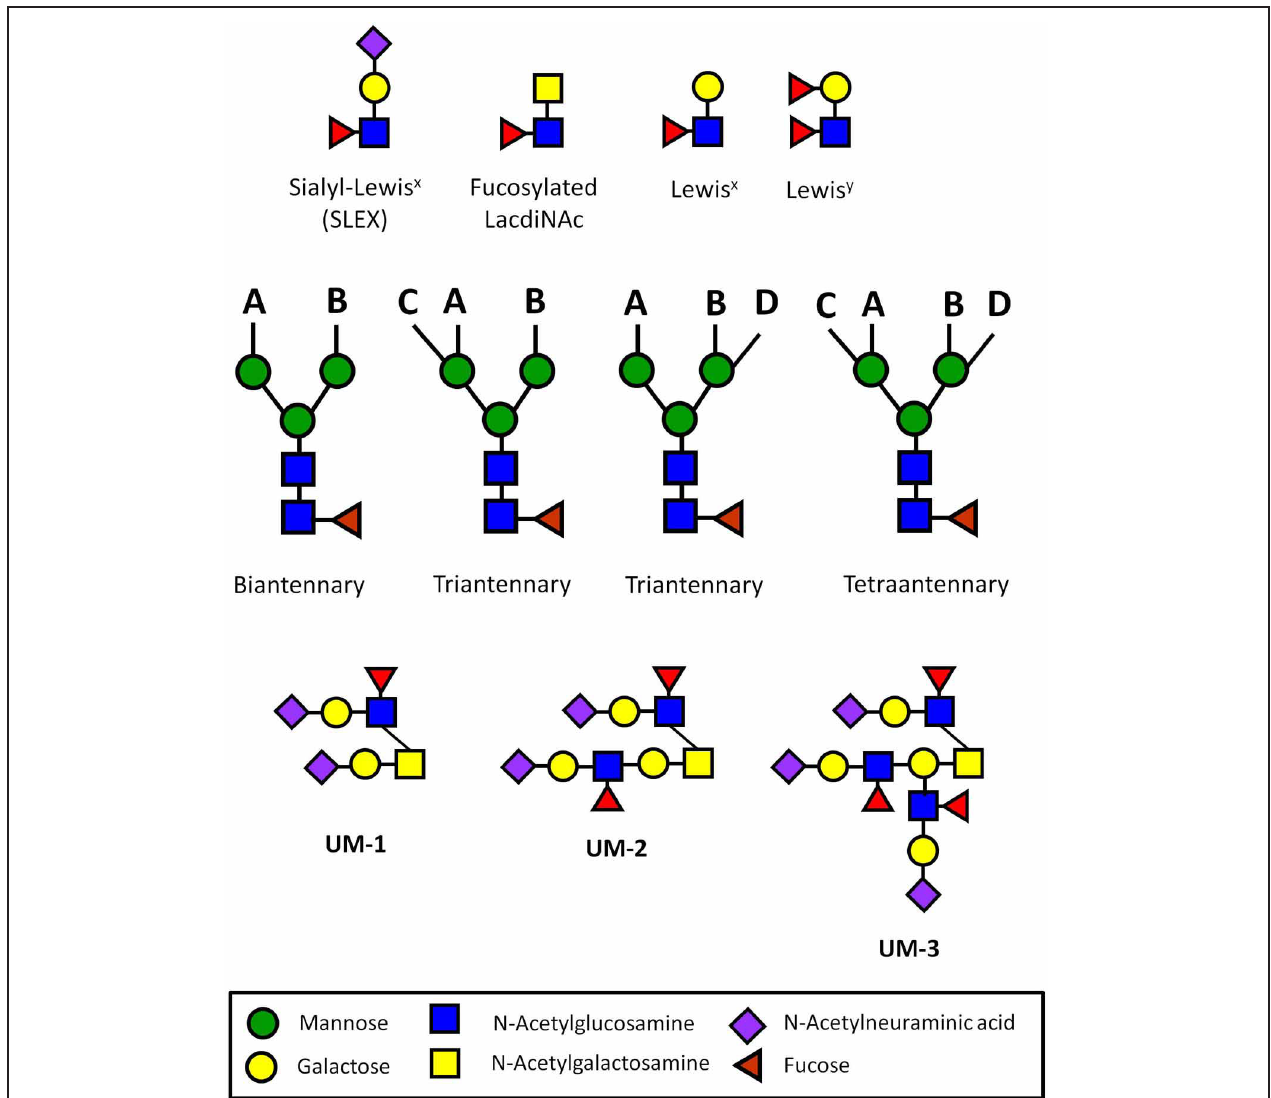
FIGURE 1 | Carbohydrate sequences involved in immune privilege in the human reproductive system. N-glycans usually have two (biantennary), three (triantennary), or four (tetraantennary) antennae linked at up to four positions (designated A–D). On the human ZP, there are biantennary and triantennary N-glycans terminated on every antenna with the SLEX sequences on every antenna (Pang et al., 2011). Tetraantennary N-glycans bearing three SLEX antenna are also present. Human sperm and seminal plasma express bi-, tri-, and tetra-antennary N-glycans